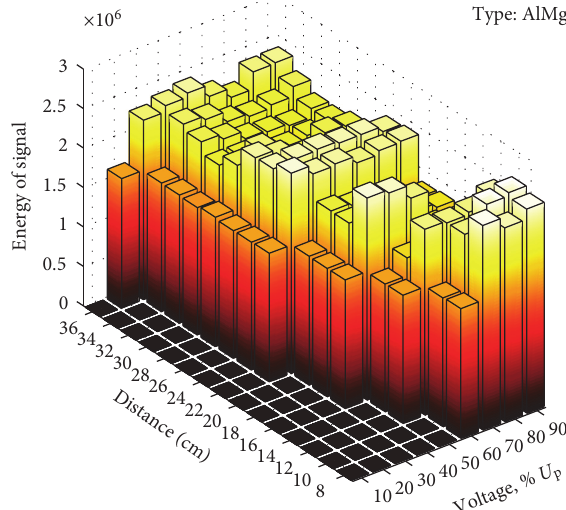
Figure 7: Dependency of voltage and distance on the value of energy of signal calculated for optical spectra emitted by corona around the FeCu